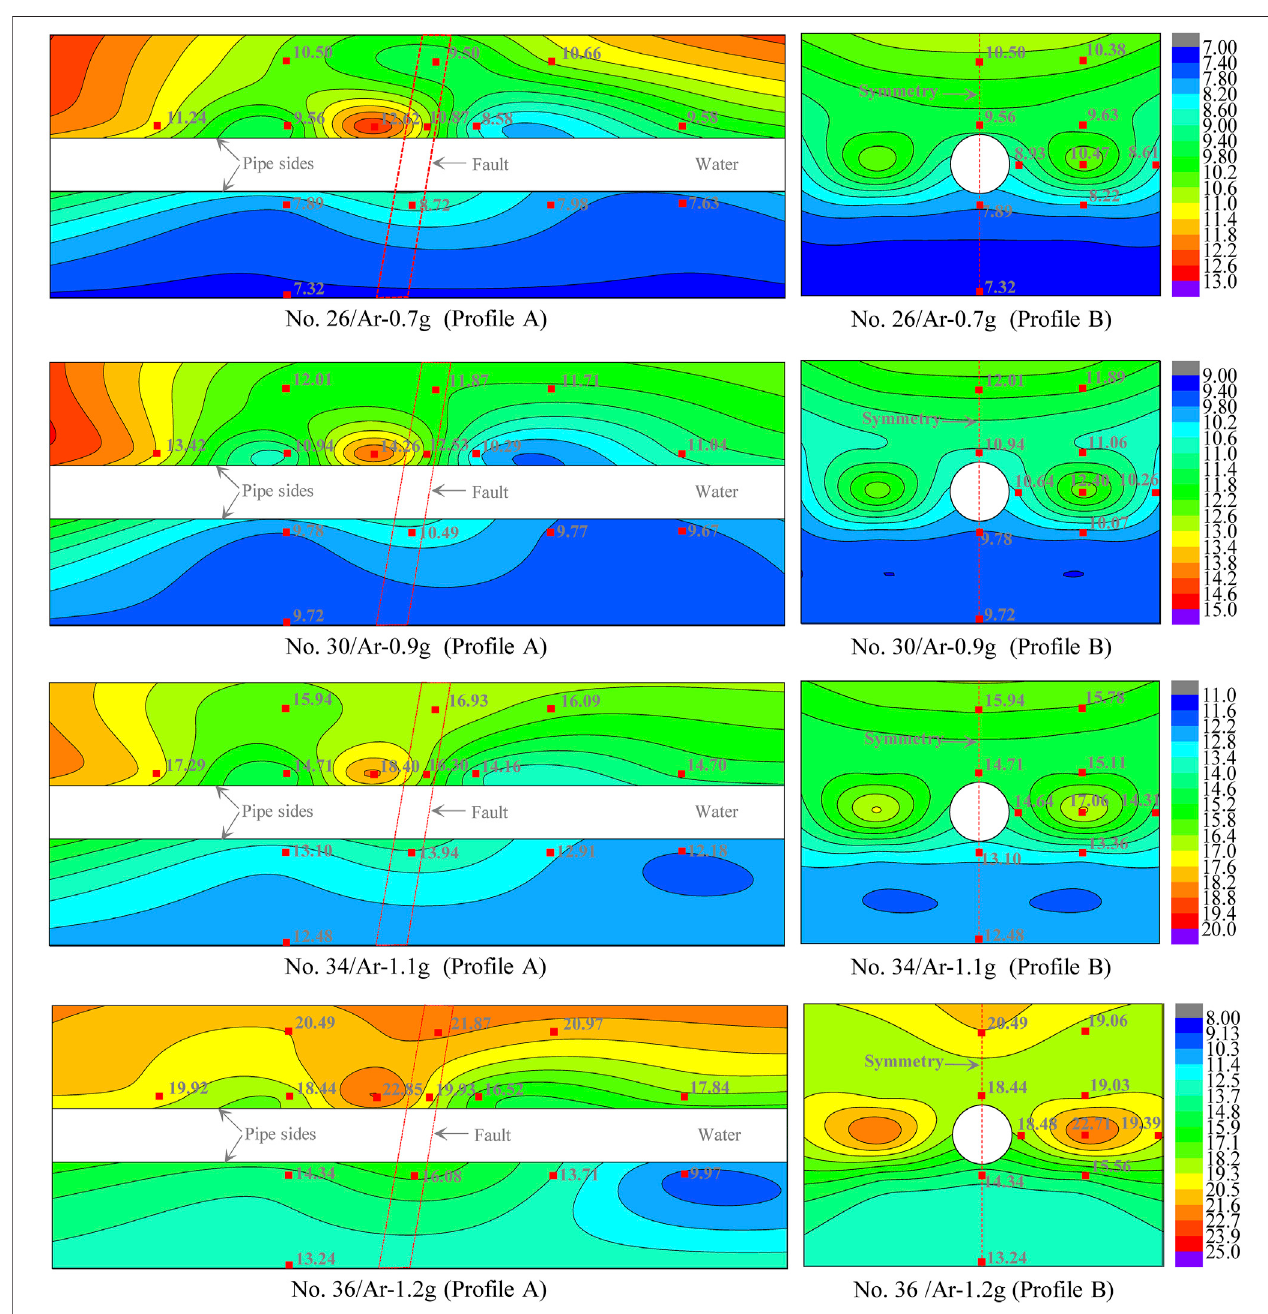
FIGURE 7 | Distribution characteristics of the peak acceleration response on pro fi les A and B (unit: m/s 2 ).